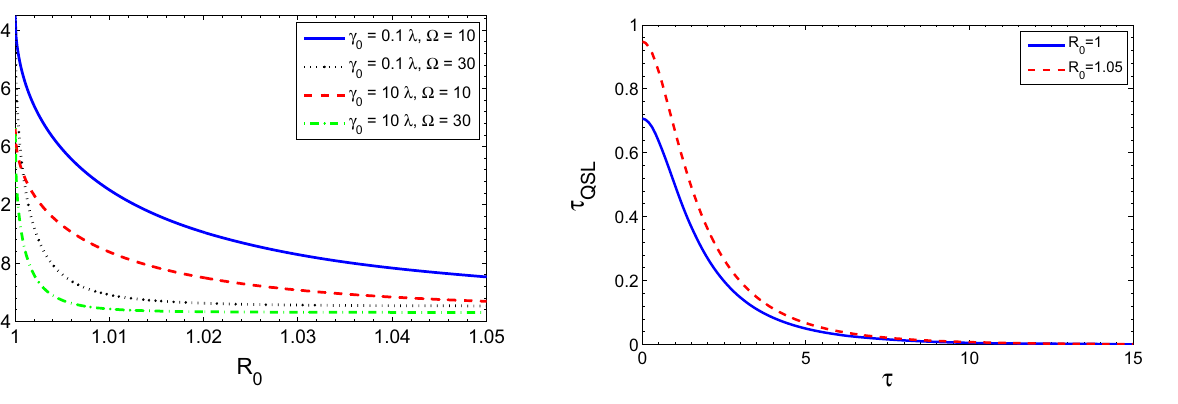
Fig. 6 The QSL-time for the damped Jaynes-Cummings model as a function of the R 0 . The value of driving time is τ D = 1 and initial time τ = 0